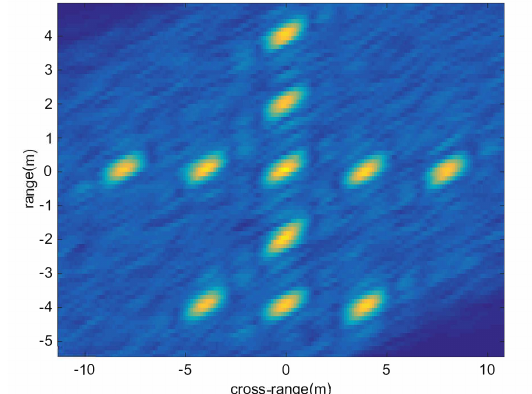
Figure 7. ( a – p ) Subimages of sixteen observation angles.